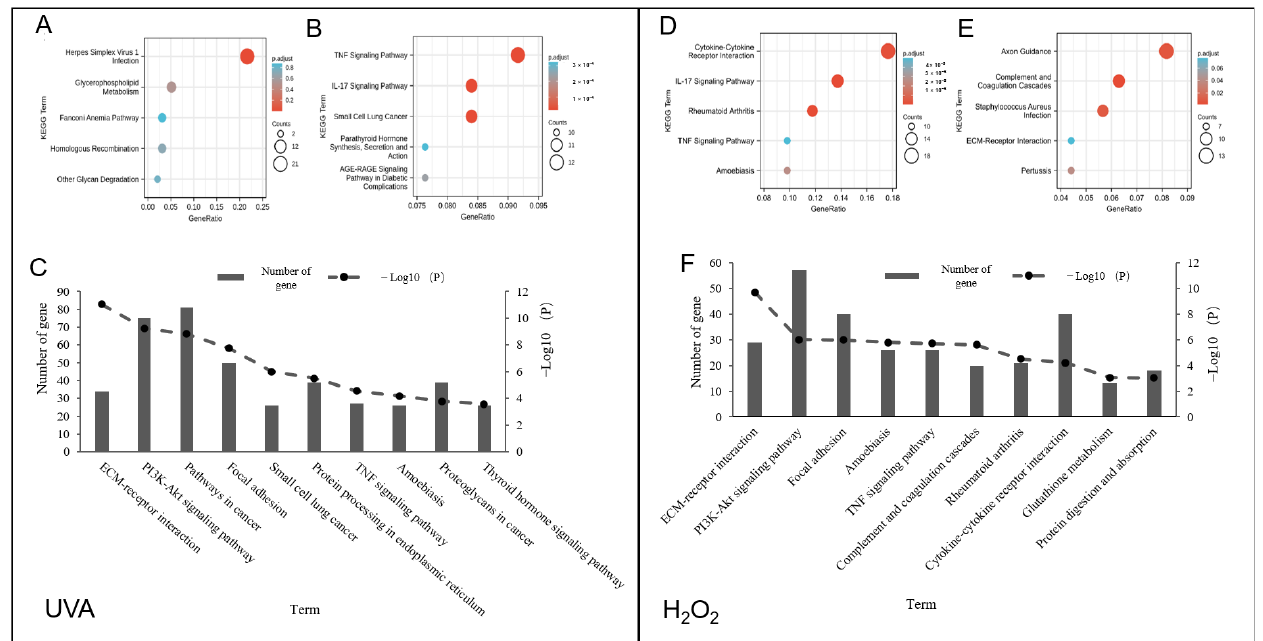
Figure 2. Bar diagrams and bubble diagrams of KEGG pathway enrichment analysis of UVA-induced ( A – C ) and H 2 O 2 -induced ( D – F ) DEGs. ( A , D ), differentially upregulated genes in each study; ( B , E ), differently downregulated genes in each study. In the bubble diagram, the vertical axis indicated GO terms and the horizontal axis represented gene ratio involved in each term. The size of dots indicated the number of genes in the GO term. The color of dots exhibited the significance. ( C , F ), the top 10 ranked KEGG terms of both upregulated and downregulated DEGs. In the bar diagram, the right vertical axis indicated the significance of each term by exhibiting a value of −log10(P), and the left vertical axis showed the number of genes involved in each term. The horizontal axis represented the top 10 ranked KEGG terms.